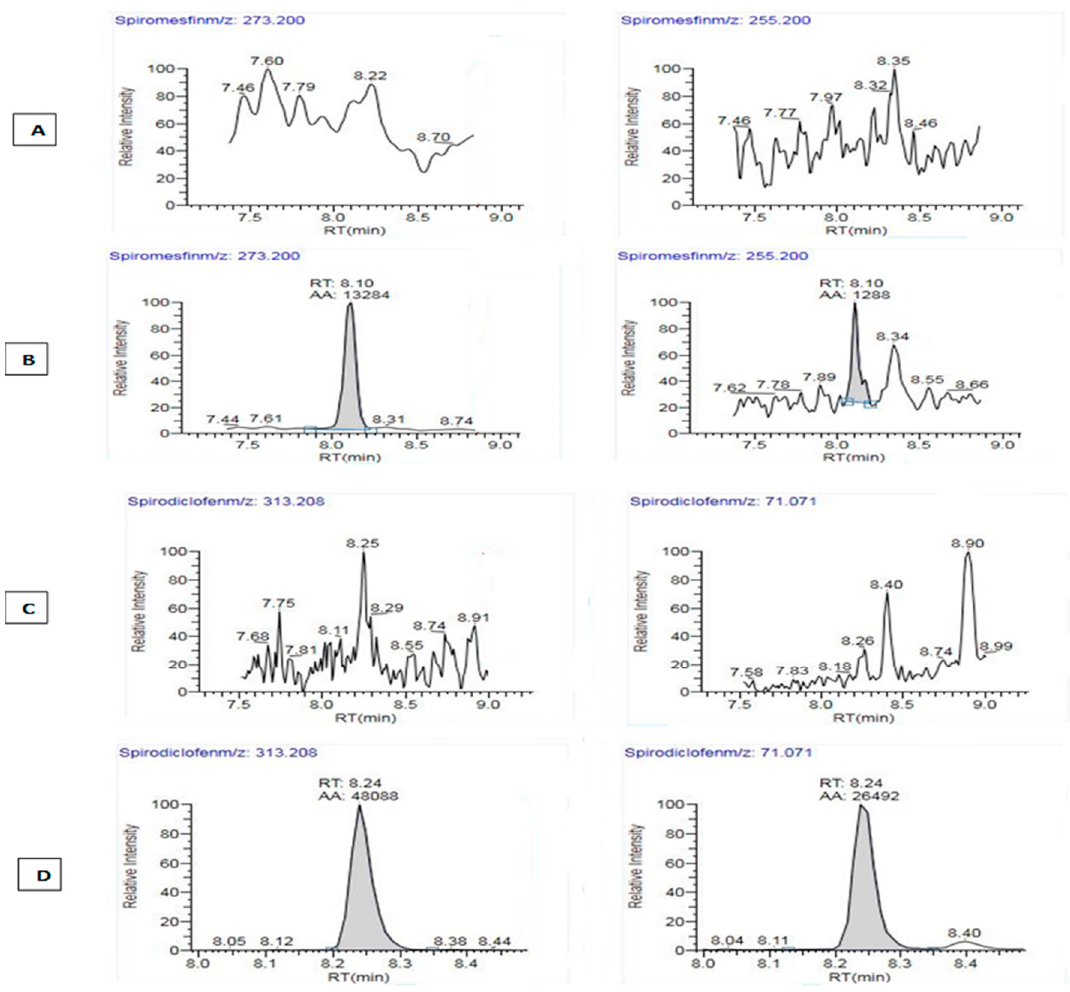
Figure 3. LC/MS/MS representative chromatograms of blank sample extract ( A , C ), spiromesifen forti fi ed sample extract (5 µg/kg) ( B ), spirodiclofen forti fi ed sample extract (5 µg/kg) ( D ). fortified sample extract (5 µ g/kg) ( B ), spirodiclofen fortified sample extract (5 µ g/kg) ( D